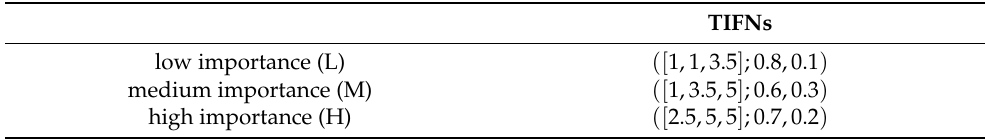
Table 1. The relative importance of